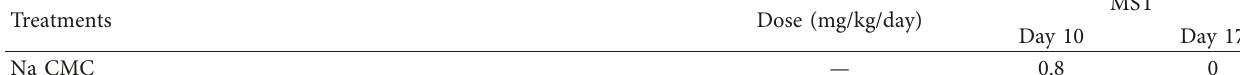
Table 5: The mean survival time (MST) of mice receiving various doses of ethanolic leaf extract of S. androgynus during prophylactic study. Treatments